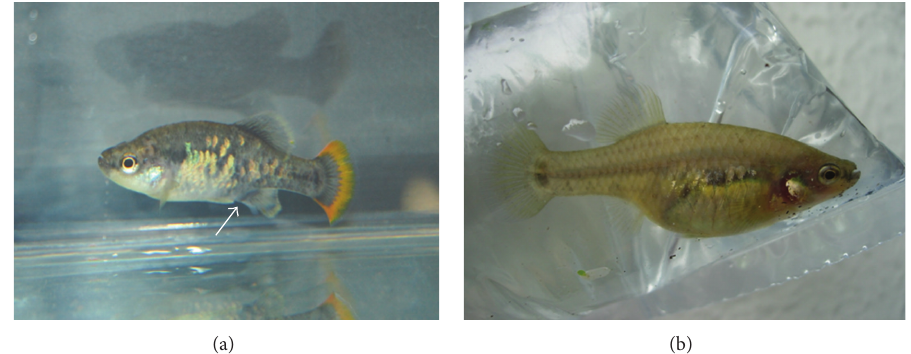
Figure 1: Adult male Z. tequila showing the typical orange-yellow band in the caudal fin and the andropodium (arrow), a copulatory organ allowing the transfer of spermatozeugmata (sperm bundles) in the female genital apparatus (a); adult female Z. tequila . Females give birth to free-swimming fry after an intraovarian gestation